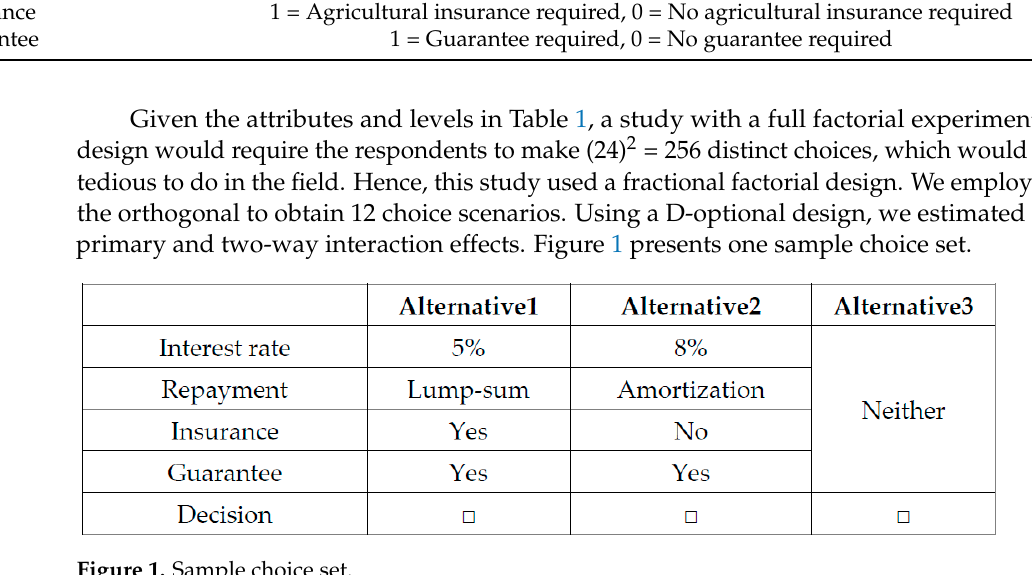
Figure 1. Sample choice